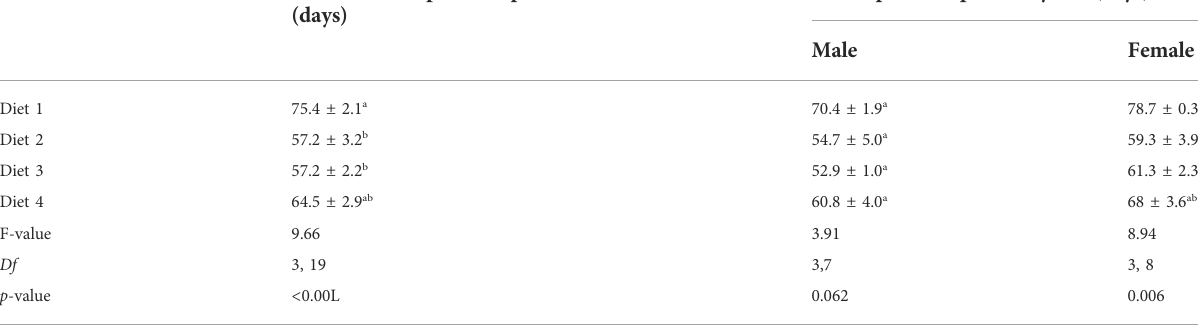
TABLE 4 Mean (±SE) development duration of Ruspolia differens reared on the different